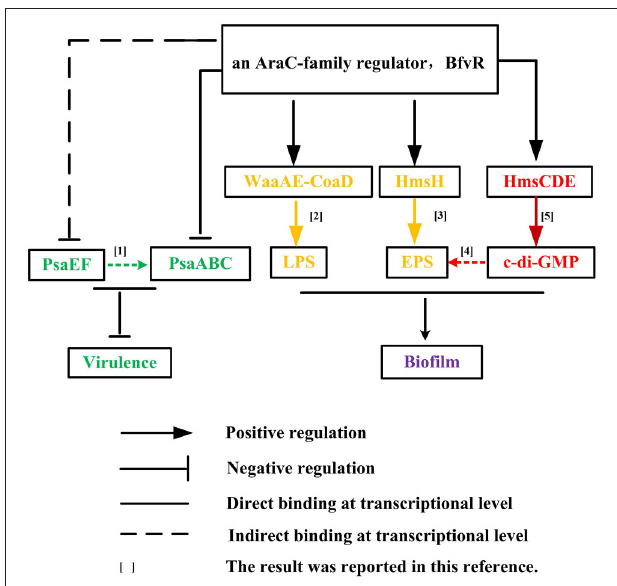
FIGURE 6 | Reciprocal regulation of biofilm formation and virulence by BfvR. The gene regulatory relationship modulated by BfvR was described in the main text and marked in black lines or arrows; while the important clues reported previously were highlighted in other colors. The corresponding literatures were listed as follows:[1] Bao et al. (2012); [2] Tan and Darby (2005); [3] Bobrov et al. (2008) ; [4] Bobrov et al. (2011); and [5] Kirillina et al.